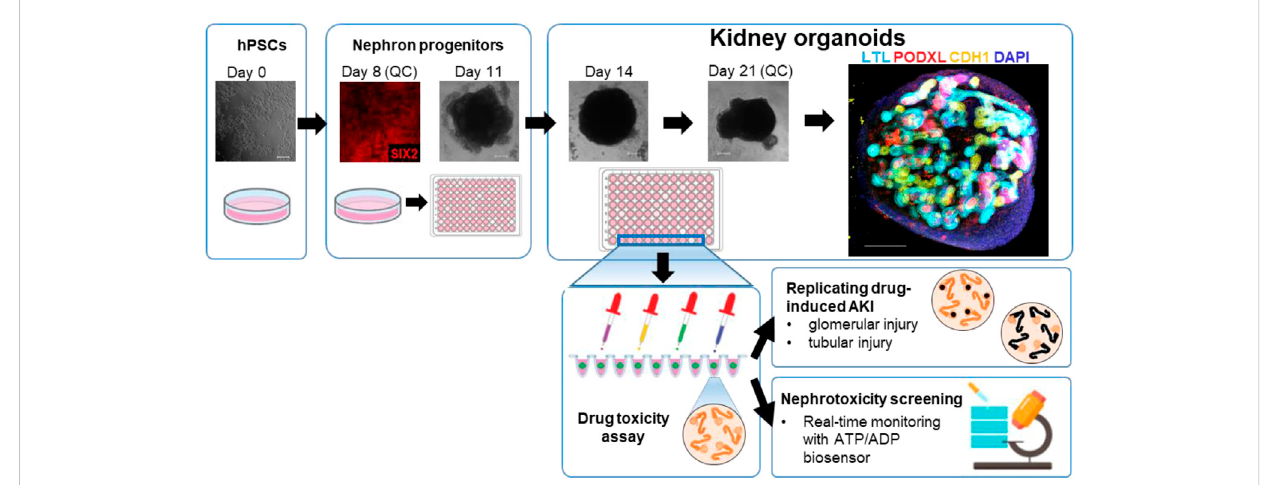
FIGURE 1 Representative steps of the generation of kidney organoids from hPSCs for the nephrotoxicity assays.